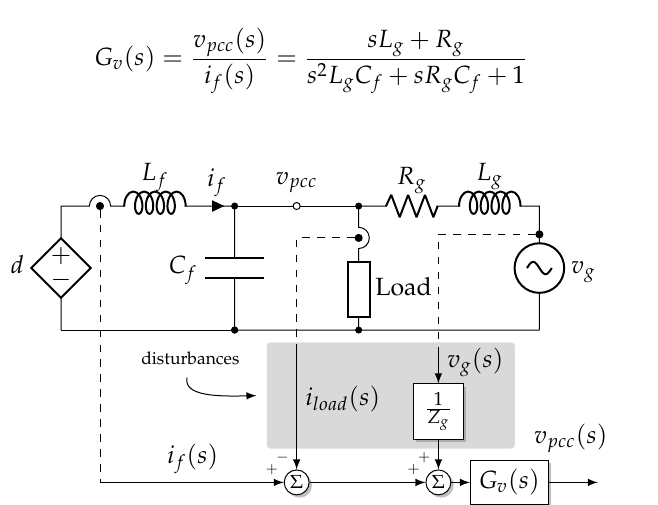
Figure 7. PCC voltage equivalent model with